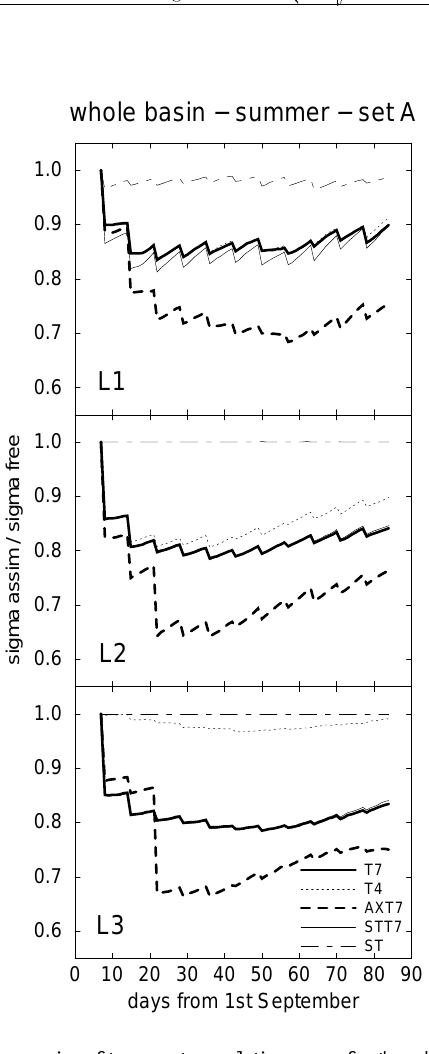
Fig. 2. Positions of AXBT deployments included in the AXT7 summer and win- ter sampling strategies. Deployments in the first week are indicated by circles and those in the second week by “plus” signs.